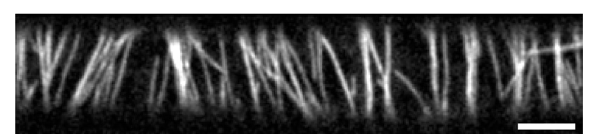
FIGURE 1 | Cortical microtubule array in 3 day old dark grown epidermal hypocotyl cell. Microtubules are labeled by mCherry-TUA5. For information about plant material and microscopy settings see Lindeboom et al. [2]. Scale bar is 5 μ m.